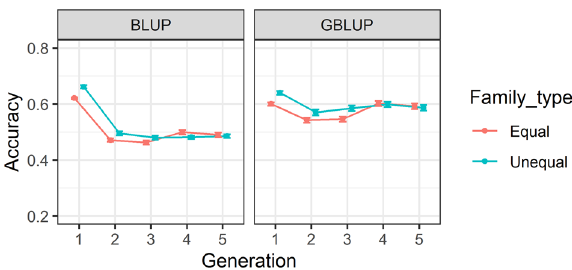
Figure 2. Accuracy of (genomic) estimated breeding values (G)EBV over five generations. The accuracies are provided for two family types (equal and unequal). Accuracies in BLUP were averaged over heritabilities and replicates, while for GBLUP are estimated by averaging correlations over three heritabilities, ten replicates, four marker densities and four genotypic error rates. Standard errors of accuracies are shown as error bars.